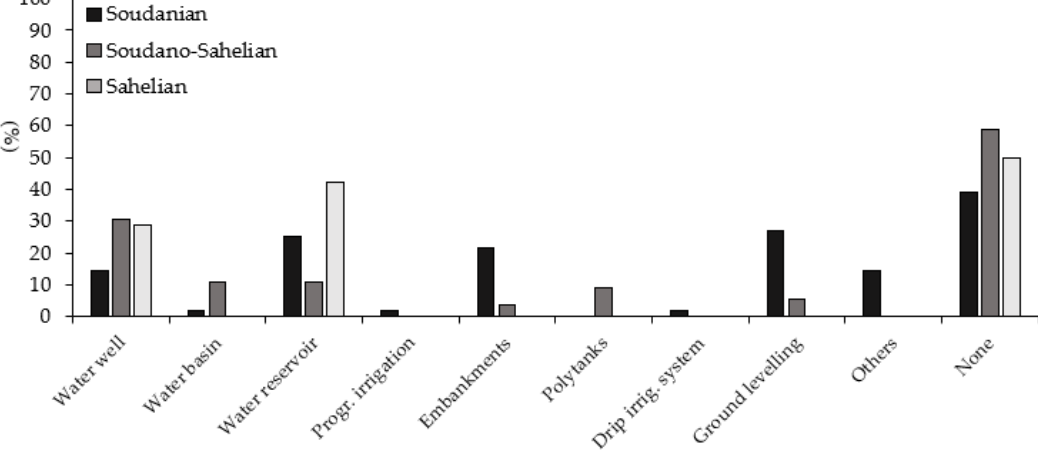
Figure 6. Water management techniques in the different agroclimatic zones (Soudanian, Soudano-Sahelian, Sahelian).